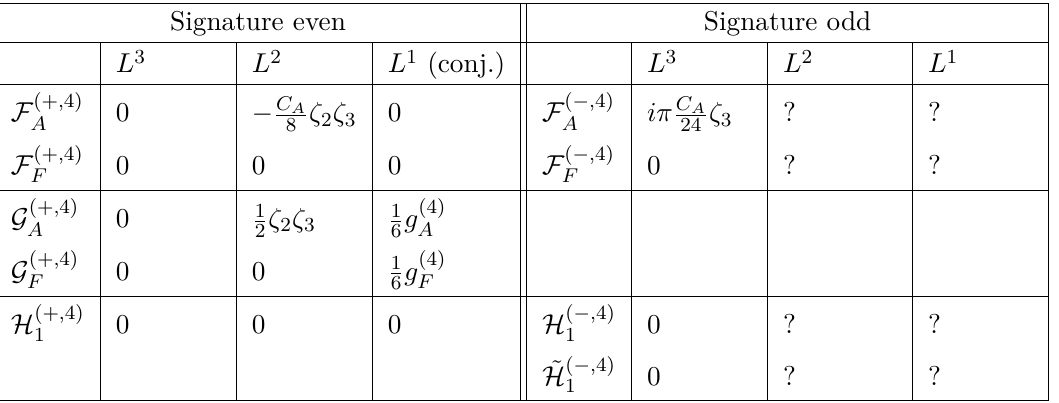
Table 1. Constraints on the high-energy limit of the kinematic functions entering the soft anomalous dimension at four loops, separated by signature. Note that G only has a signature-even component, and H (4) is purely gluonic. All constraints at order L 3 and L 2 in this table are based on explicit 1 computations in the high-energy limit, while those for order L 1 are based on the conjectured generalisation of the relation between cusp singularities and the Regge pole to four loops. The coefficients g (4) are known in QCD [68–75] and are quoted in eq. (B.3). R